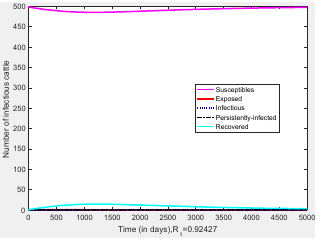
Figure 9. Number of cattle in each Figure 10. Number of infectious compartment with baseline parameter cattle with initial values I 0 = 1 , values in Table 3 except a = 0 . 23 and S 0 = 499 and V 0 = E 0 = Q 0 = with initial values I 0 = 1 , S 0 = 499 R 0 = 0 and with baseline parameter and V 0 = E 0 = Q 0 = R 0 = 0 values in Table 3 except b = 0 . 1 and converging to its DFE ( S 0 = 500 , a = 0 . 017 . A backward bifurcation E 0 = I 0 = Q 0 = R 0 = 0). The occurs for these parameter values with system has a forward bifurcation for R ∗ t = 0 . 1161 < R t = 0 . 6542 < 1; the these parameter values with system converges to its EE ( S (cid:63) = 80 , R t = 0 . 9243. E (cid:63) = 9 ,I (cid:63) = 11 ,Q (cid:63) = 19 ,R (cid:63) =